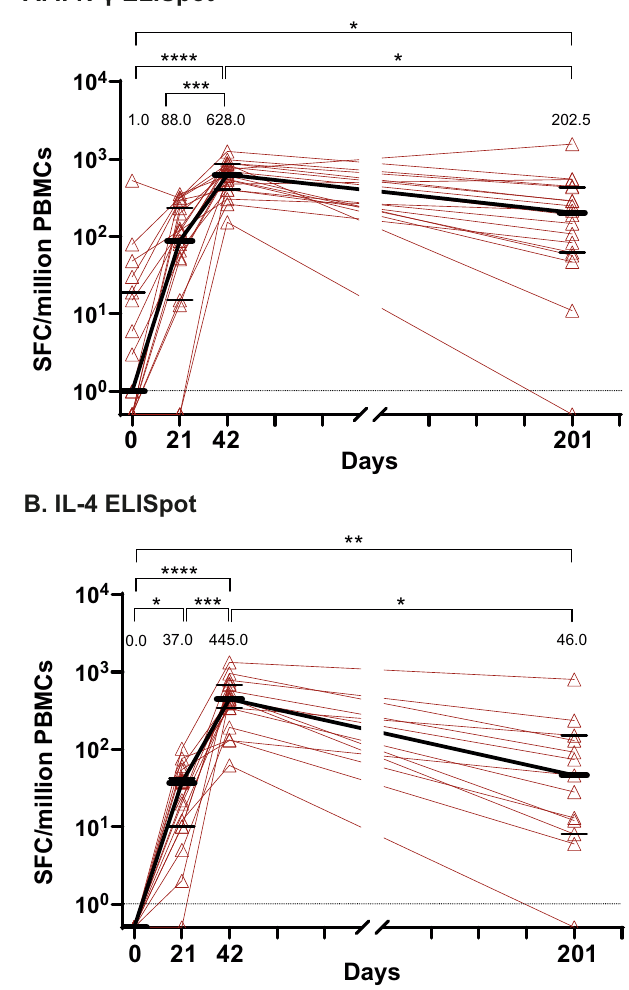
Fig. 4 | Durability of cellular immune responses. Antigen-speci fi c IFN- γ and IL-4 responseswerequanti fi edbyELISpot.Frequenciesofspike-speci fi ccellsproducing ( A) IFN- γ and ( B) IL-4 per million PBMCs at baseline (D0) and 21 days after one immunization (D21), or two immunizations (D42), and D201 post-immunization with 3.75 µ g CoVLP adjuvanted with AS03 were measured after ex vivo restimula- tion with a peptide pool consisting of S protein-derived 15-mer peptides over- lappingby11aminoacids.ForIFN- γ ,vaccinatedsubjects( n =19)atD0,21,42andat D201 ( n =18) were included in the analysis. For IL-4, vaccinated subjects at D0 ( n =14), D21( n =17),D42 ( n =19) and atD201( n =13)wereincluded inthe analysis. Individualvaluesareindicatedbyredlines;mediansareindicatedbyblacklinesand numerical values. Error bars indicate 95% CI. Signi fi cant differences between timepoints are indicated by asterisk(s) (* p <0.05; ** p <0.01; *** p <0.001; **** p <0.0001; Friedman test followed by Dunn ’ s comparisons test, GraphPad Prism, v9.0). SFC Spot Forming Cell count.